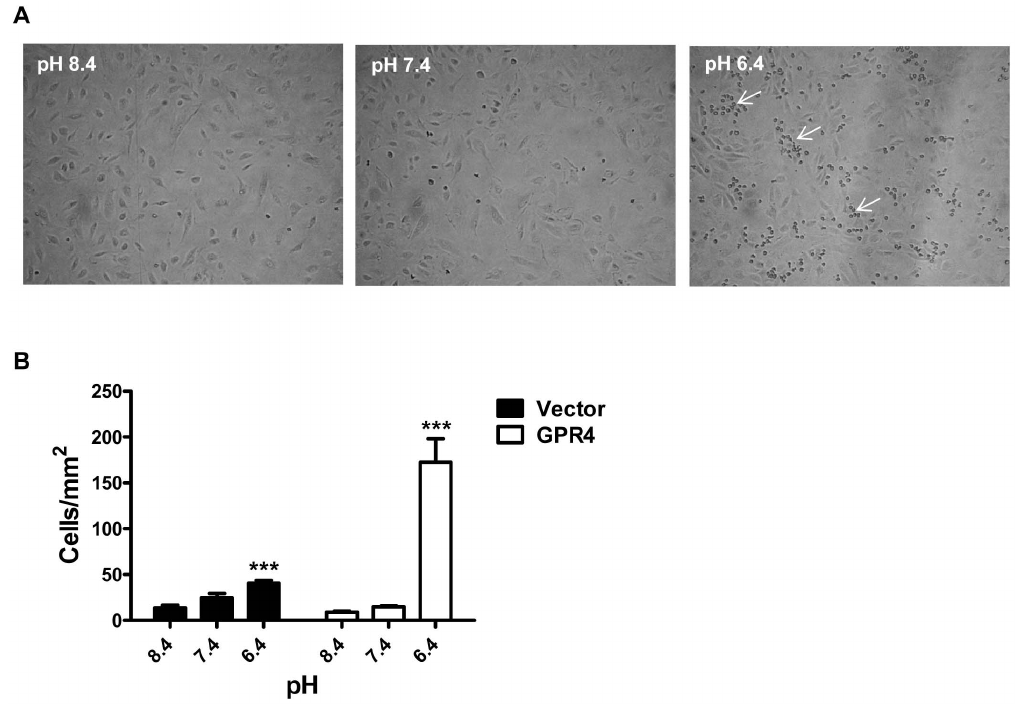
Figure 7. Increased binding of U937 monocytes to vascular endothelial cells treated with acidic pH. (A) U937 monocytic cells were adherent to acidic pH-treated HUVEC/GPR4 cells under a flow condition. Representative pictures are shown with the adhered U937 cells indicated by arrows. (B) HUVECs stably overexpressing GPR4 or control vector were grown to a monolayer, and were treated with EGM-2/HEM pH 8.4, 7.4 or 6.4 media for 5 h. U937 monocytes were adhered to the pH-treated HUVEC monolayer under a flow condition (0.5 dyne/cm 2 ). Error bars indicate the mean 6 SEM. ***, P , 0.001; compared with the pH 8.4 groups. The results represent the average of cell counts from 6 fields.